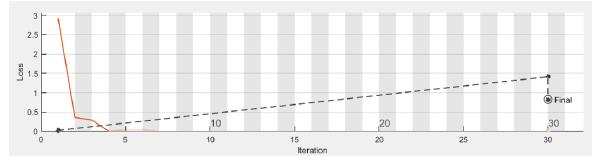
Figure 11. Loss rate of CNN during training